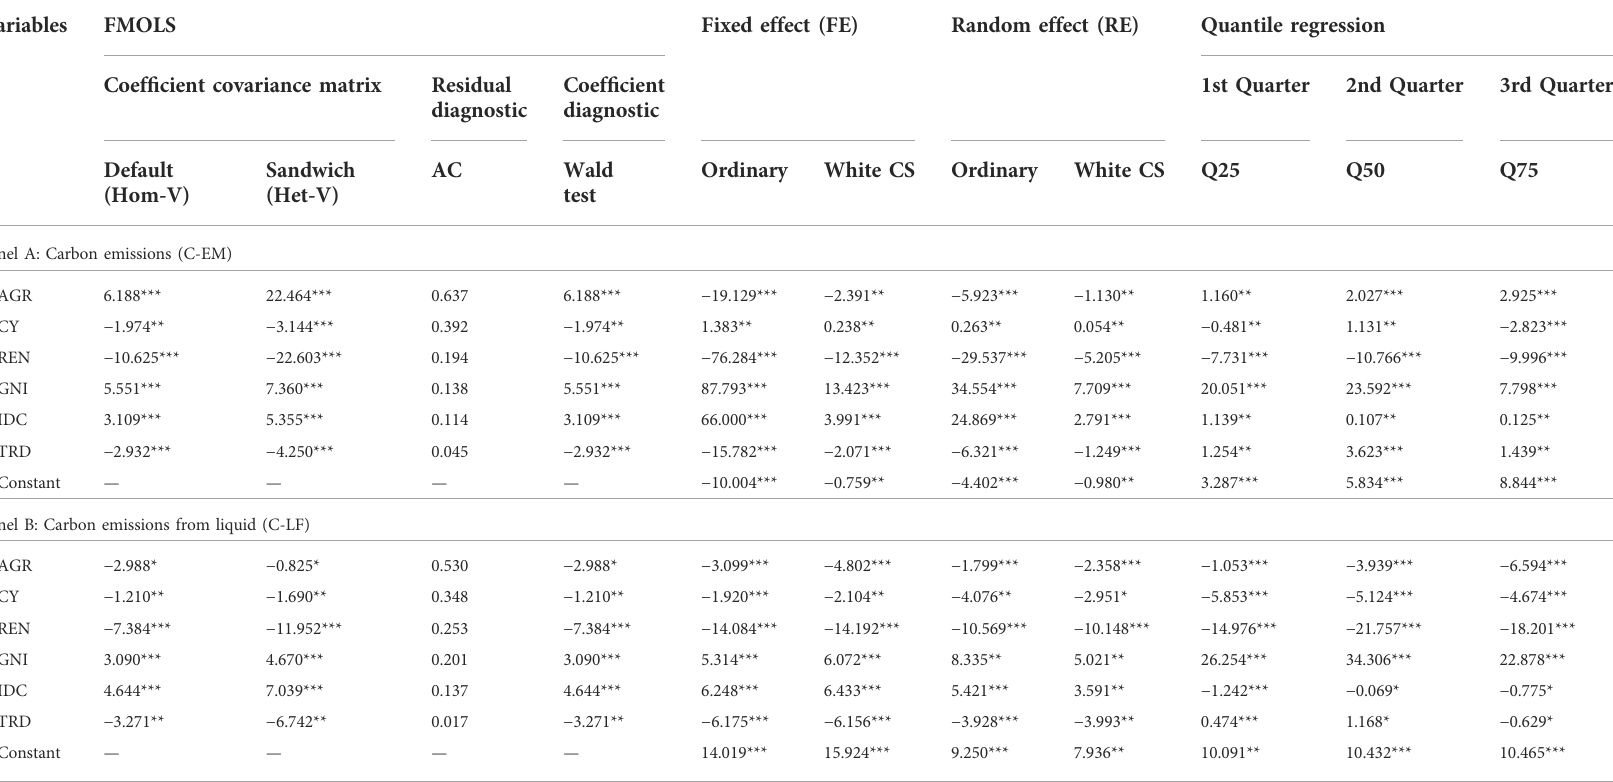
TABLE 4 FMOLS, RE, Random Effect; FE, Fixed Effect; Quantile regression across countries.